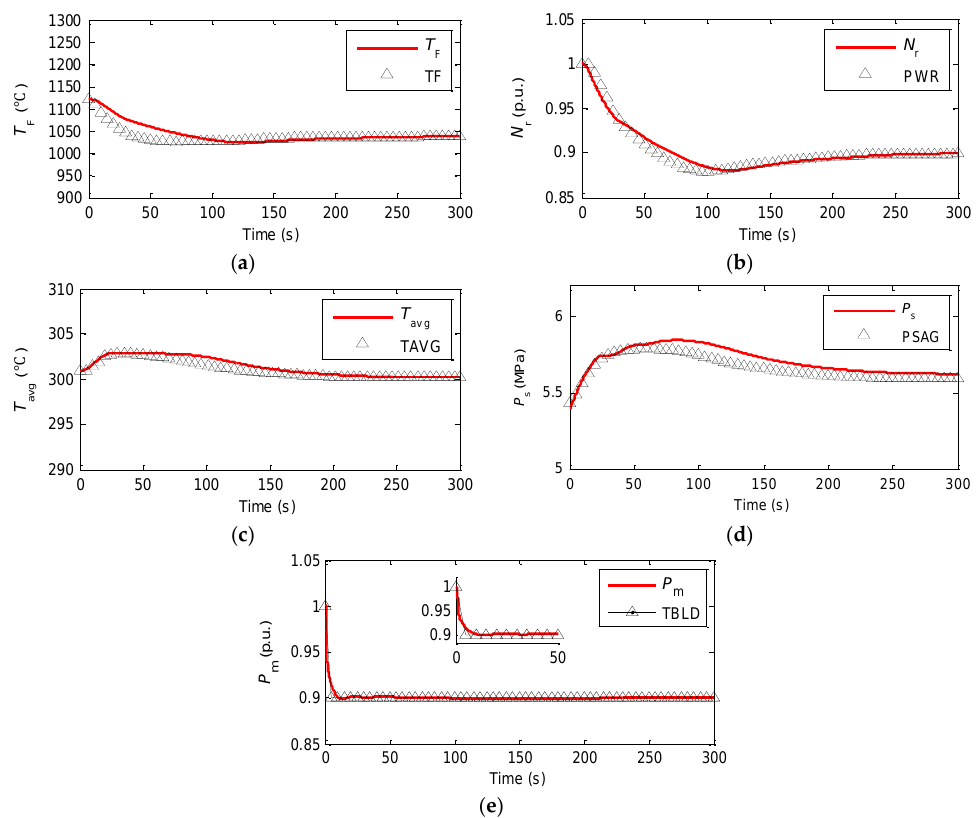
Figure 18. Response of AP1000 with power disturbance. ( a ) Change of T F ; ( b ) change of reactor thermal power; ( c ) change of T avg ; ( d ) change of P s ; and ( e ) change of P m .